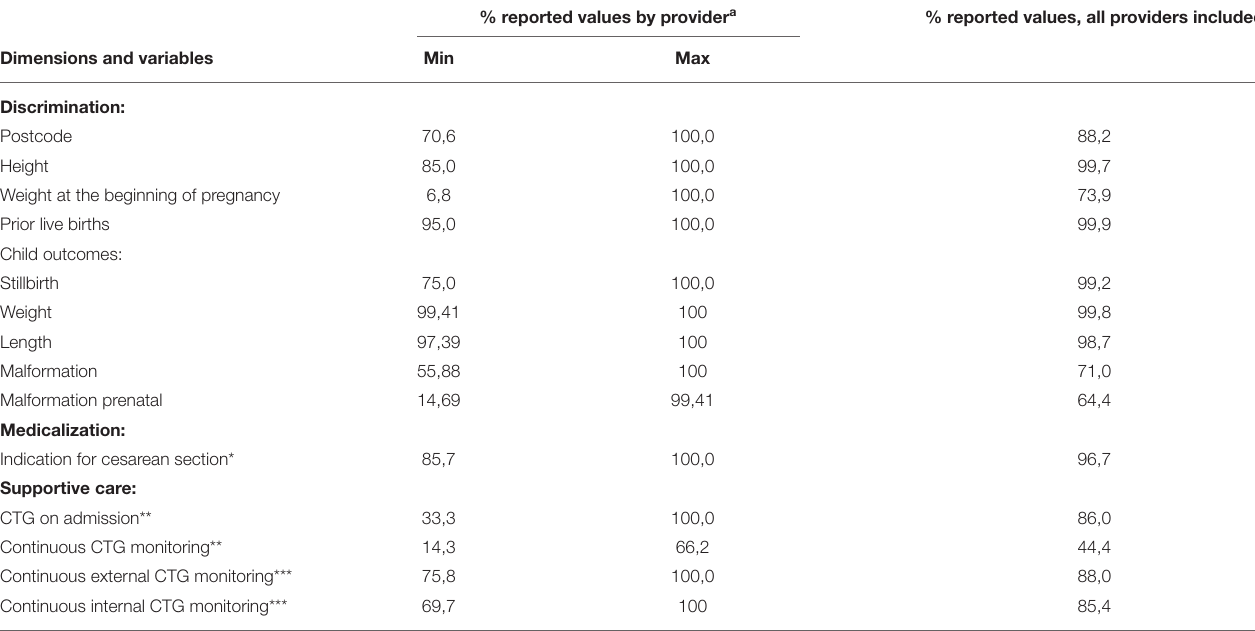
TABLE 2 | Completeness (%) of vBI-related variables across providers and total percentage of reported values. % reported values by provider a % reported values, all providers